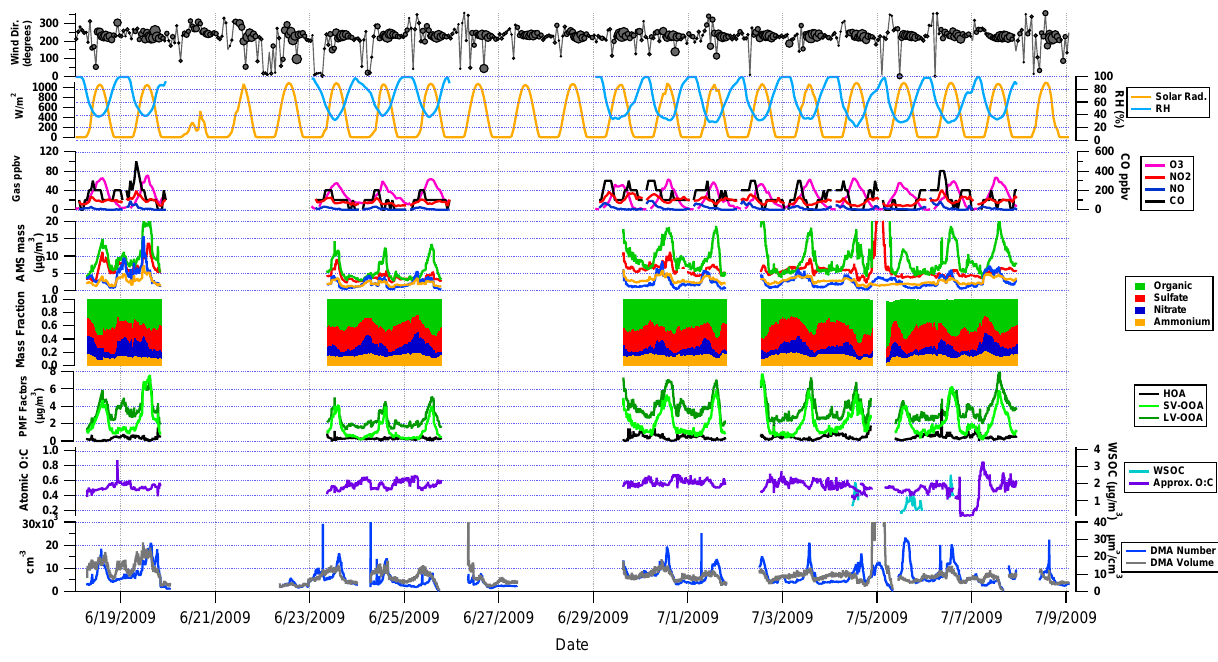
Fig. 1b. Regime II (wind direction marker size proportional to wind speed; max size = 20 km/h).